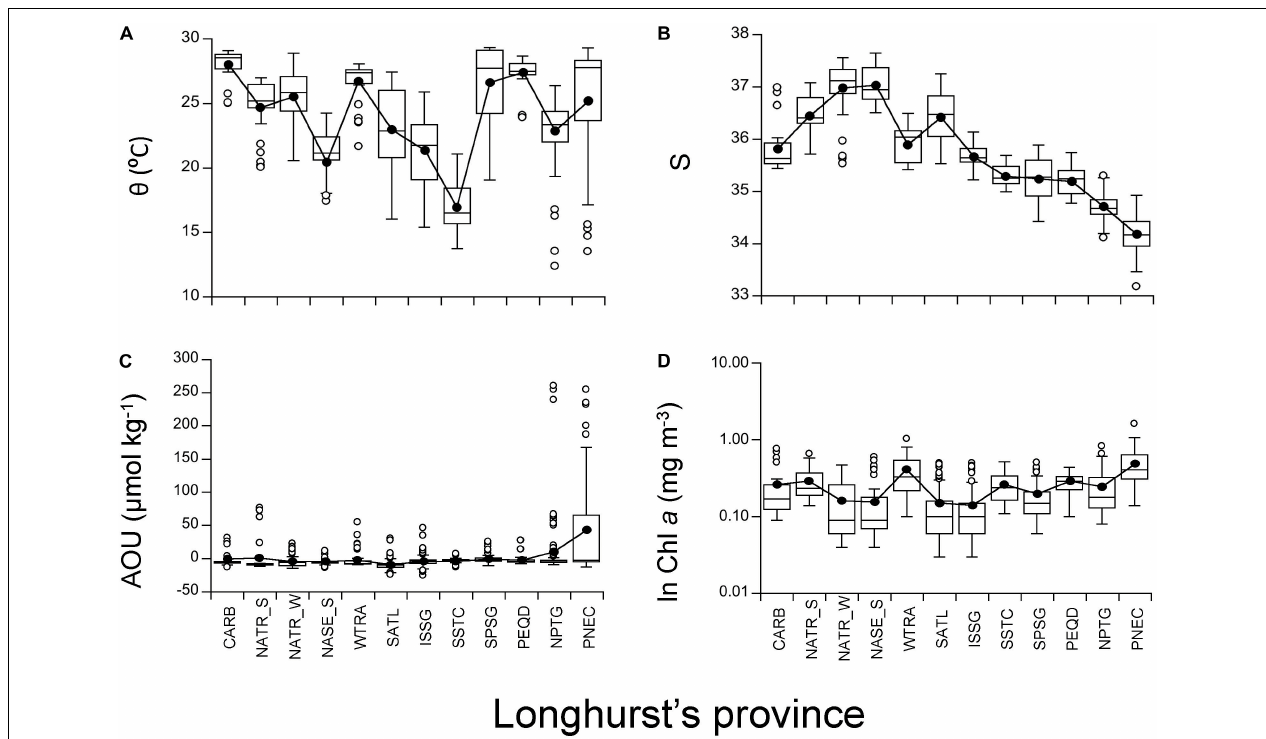
FIGURE 4 | Box and Whisker plots applied to the four physical, chemical and biological explanatory variables at each biogeographic province. Horizontal line represents median; black circles represent means; white-box represent 25–75% percentiles and whiskers extend from the upper (lower) to the highest (lowest) value that is within 1.5x inter-quartile range of the hinge. Solid black line connects all mean values for each Longhurst’s province among the oceans. (A) Potential temperature, (B) Salinity, (C) AOU, and (D) Chl a . Note that Chl a was